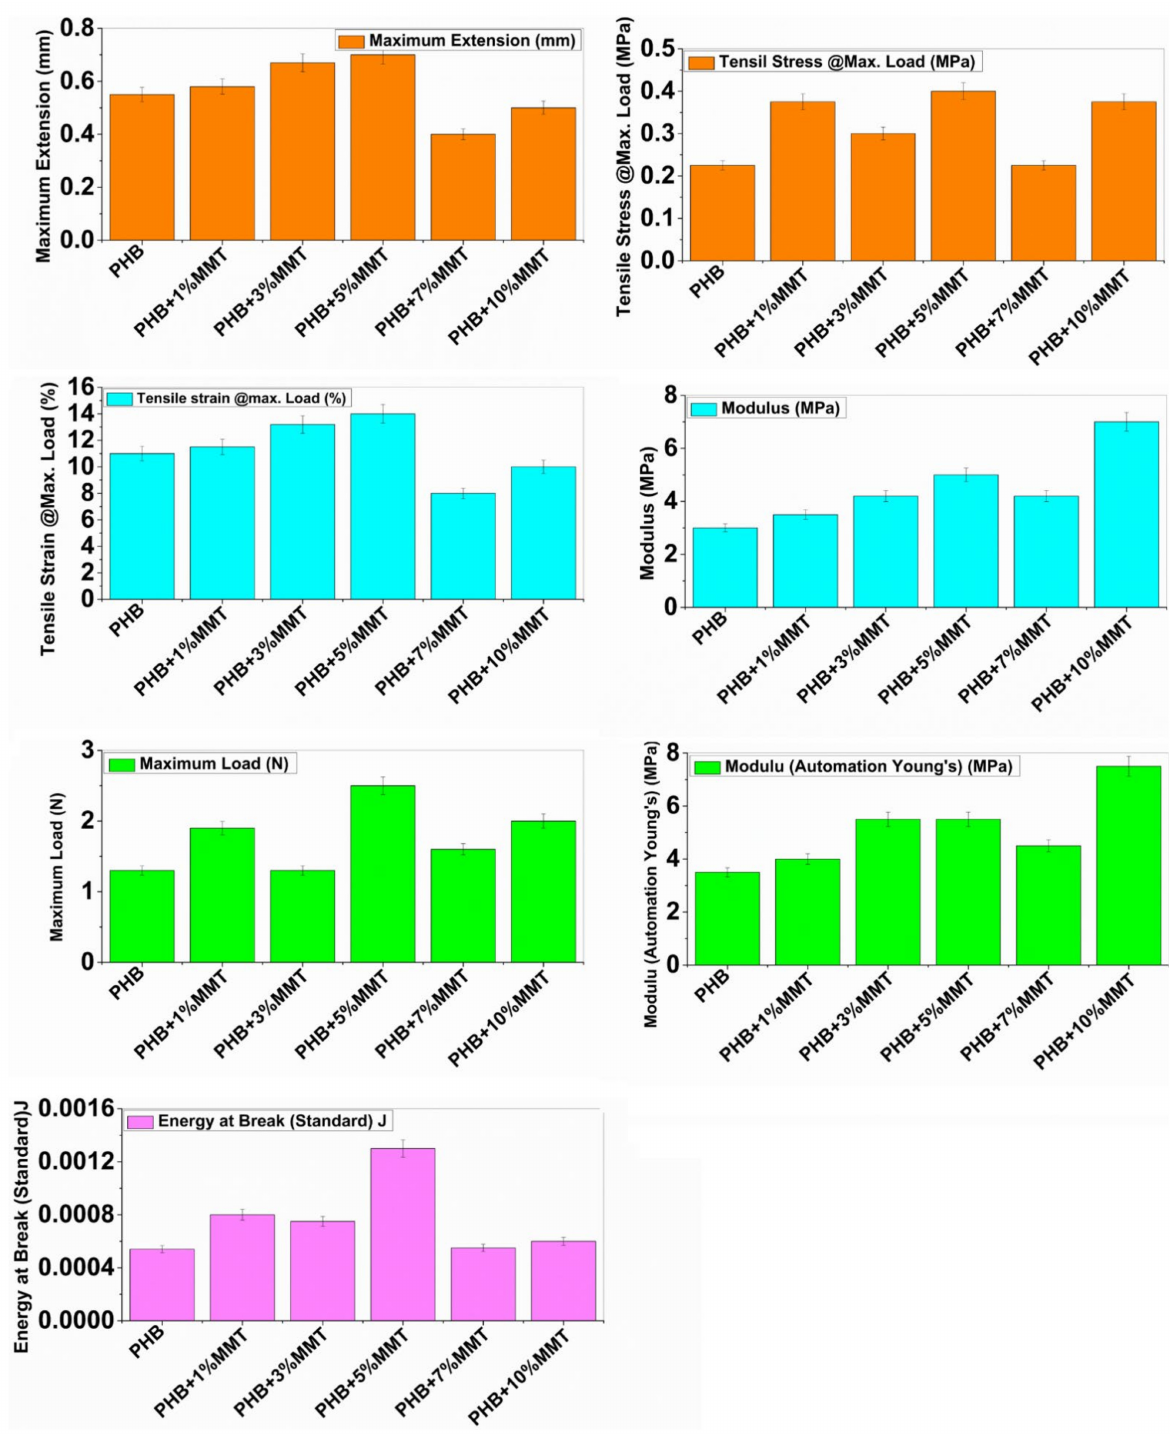
Figure 5. Instron mechanical testing parameters of neat PHB and different PHB